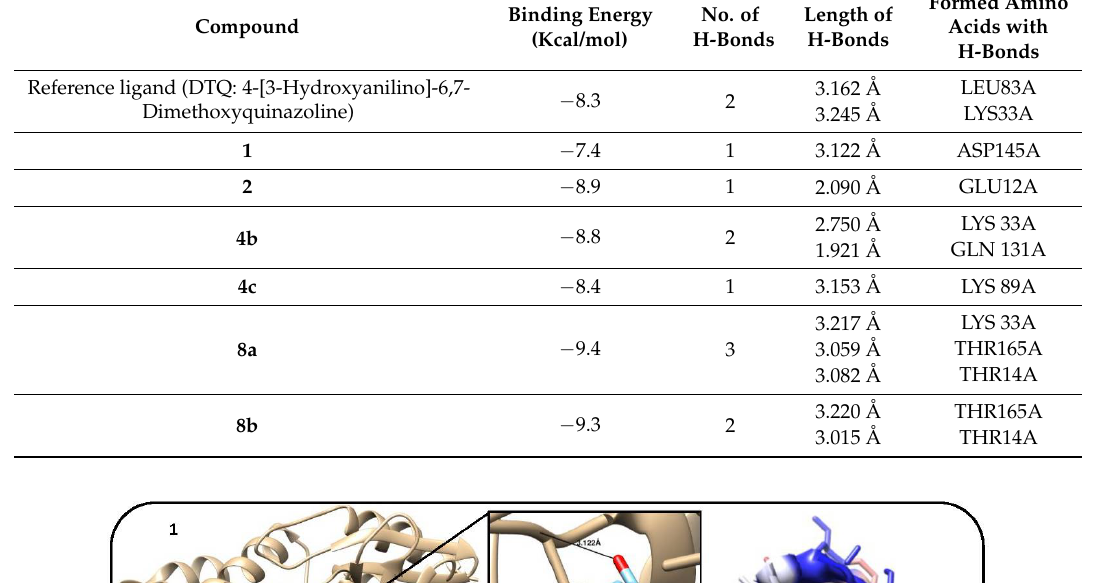
Table 2. The results of molecular docking of best conformer with 1di8 receptor. Compound Binding